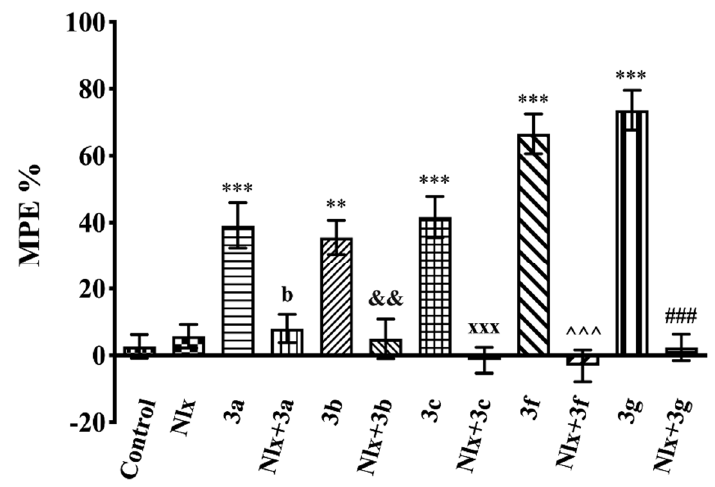
Figure 7. Effect of naloxone (5.48 mg/kg, i.p.) pre-treatment on antinociceptive activity induced by compounds 3a – 3c , 3f , and 3g in the tail-clip test. Significance against control group ** p < 0.01, *** p < 0.001; significance against compound groups: 3a b p < 0.01; 3b && p < 0.01; 3c xxx p < 0.001; 3f ^^^ p < 0.001; 3g ### p < 0.001. Values are mean ± SEM. One-way ANOVA and post-hoc Tukey’s test, n = 7.